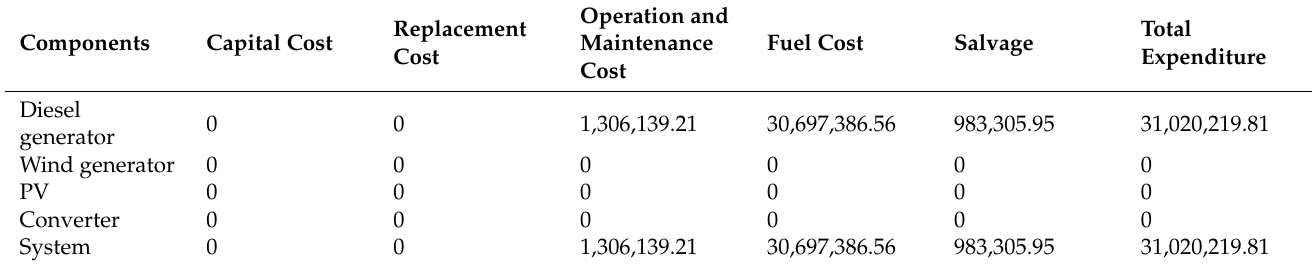
Table 10. Cost detailed of the base case (diesel-only)